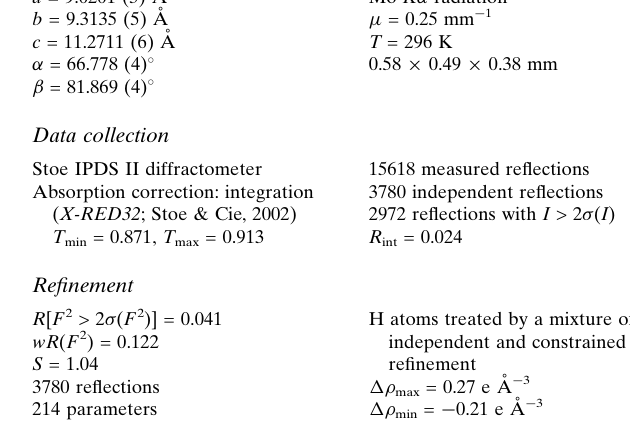
Stoe IPDS II diffractometer Absorption correction: integration